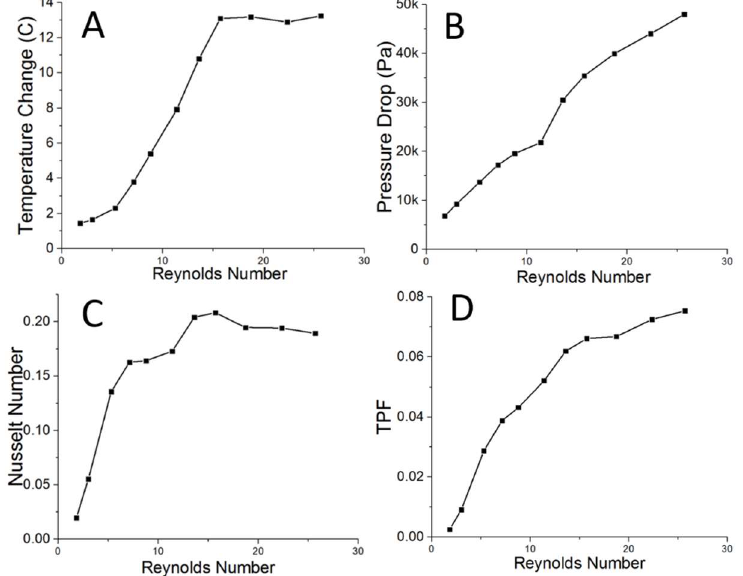
Figure 4. The experimental results of the dual-channel rolled-up microfluidic system. The device was mounted into the two-loop experimental setup shown in Figure 2B. The hot water and cold water were separately injected into a hot channel loop and cold channel loop in the rolled-up device, respectively. The change in temperature of the hot water stream was plotted against the Reynolds number ( A ) showing good heat transfer between hot and cold channels. ( B ) The pressure drop was plotted against the Reynolds number, showing no leakage in our device. ( C ) The thermal performances of the dual-channel rolled-up device were determined via the Nusselt number and thermal performance factor (TPF), which are plotted against Reynolds number as shown in ( C , D ), respectively. In this thermal test, the fluidic flow rates were varied from 0.6 to 8.5 mL/min corresponding to Re of 2 to 26.